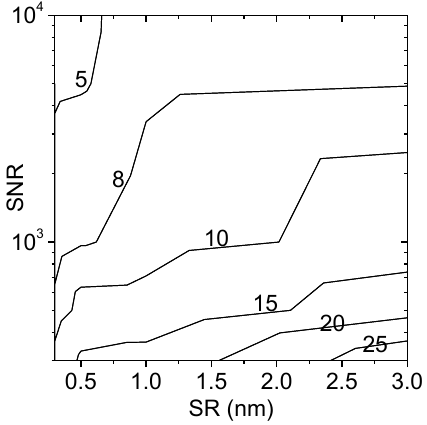
Figure 7. Contours of the full-spectrum RRMSE (%) in the SIF retrieved by the F-SFM algorithm using simulated test datasets with different SRs and